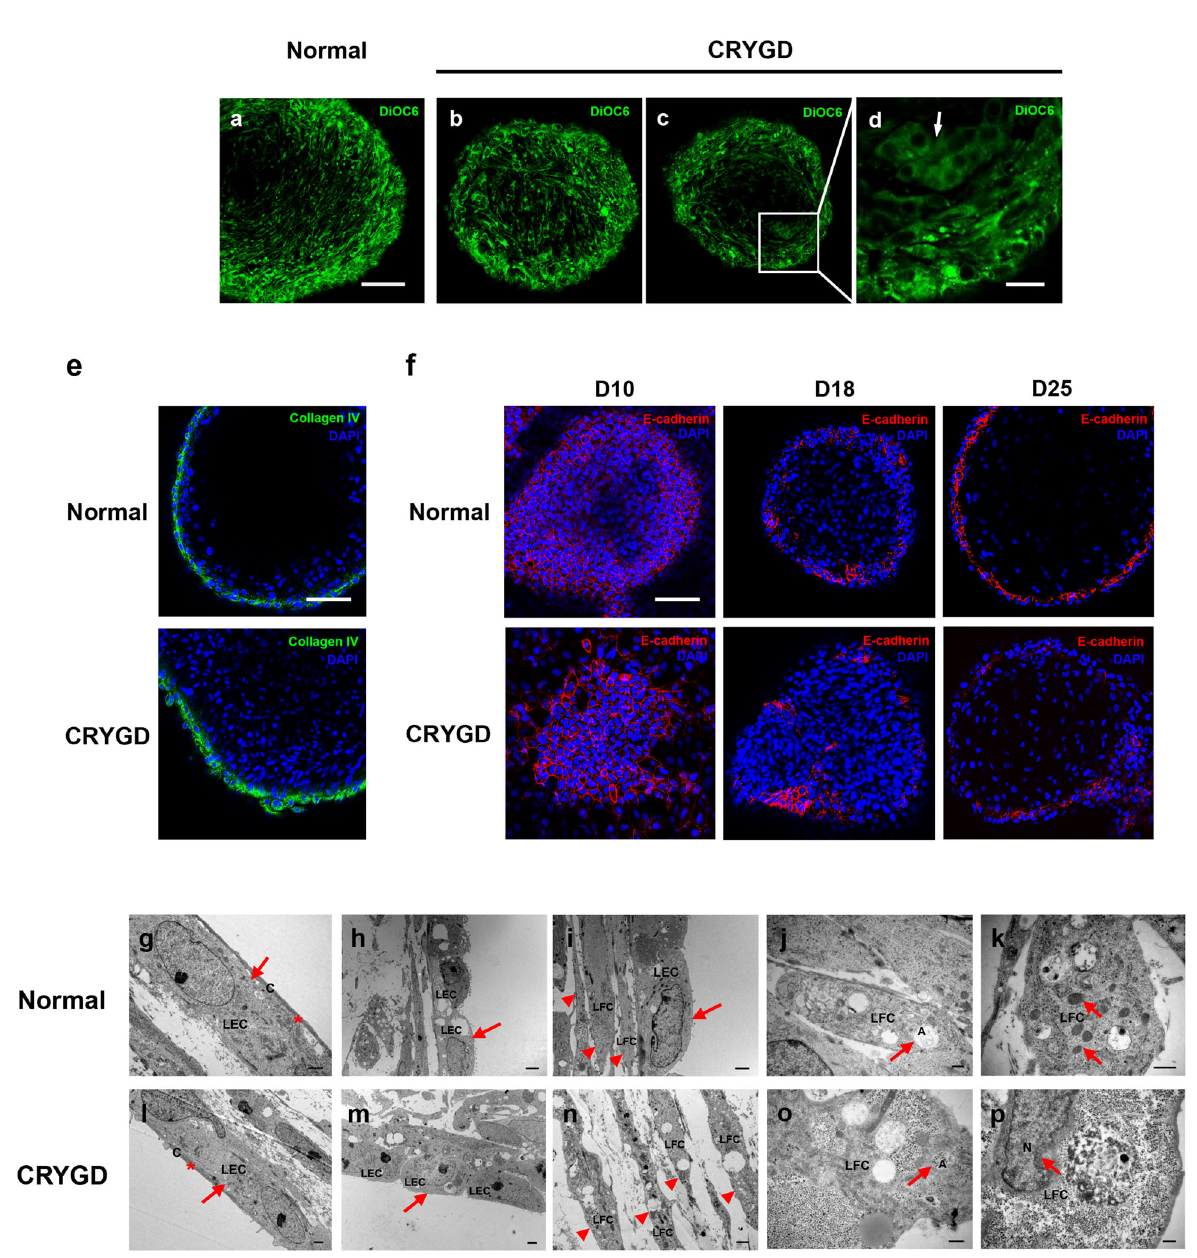
Fig. 4 Structural analysis of the normal and the CRYGD -mutated LBs. a – d DiOC6 staining of the normal ( a ) and CRYGD -mutated LBs ( b – d ) on D25. The white arrow indicates cord-like structures in the CRYGD -mutated LBs. Scale bar: ( a – c ) 100 μ m, ( d ) 25 μ m. e Immuno fl uorescence analysis of collagen IV in the normal and CRYGD -mutated LBs on D25. Scale bar: 100 μ m. f Immuno fl uorescence analysis of the lens epithelial marker E-cadherin in the normal and CRYGD -mutated LBs on D10, D18, and D25. Scale bar: 100 μ m. g – p TEM images of the normal and CRYGD - mutated LBs on D25. Lens capsules (asterisks in g and l ), lens epithelial cells (arrows in g , h , i , l , and m ), and differentiating lens fi ber cells ( j , k , o , and p , arrow heads in i and n ) with degenerating nuclei (arrow in p ), degenerating organelles (arrow in k ), and autophagosomes (arrows in j and o ). Scale bars: ( g , l , and n ) 1 μ m, ( h , i , and m ) 2 μ m, ( j , k , o , and p ) 0.5 μ